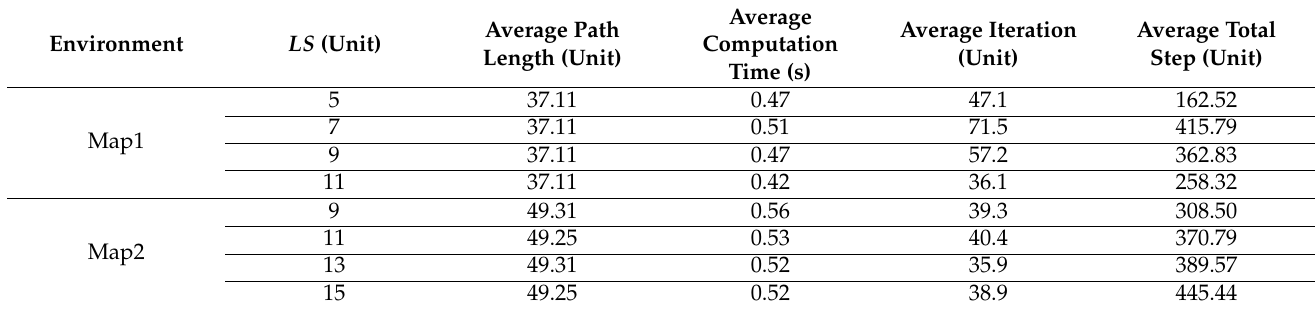
Table 7. Local Environment Average Performance Comparison.